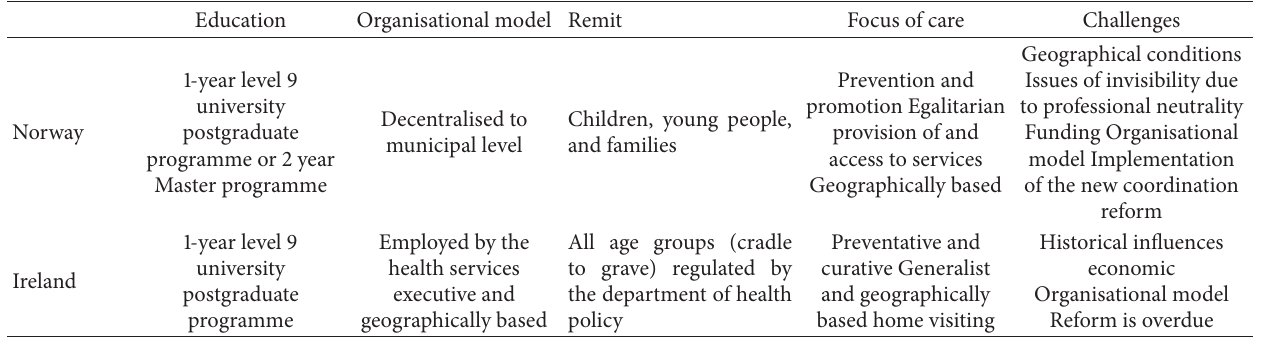
Table 2: Public health nursing: key similarities and differences between Ireland and